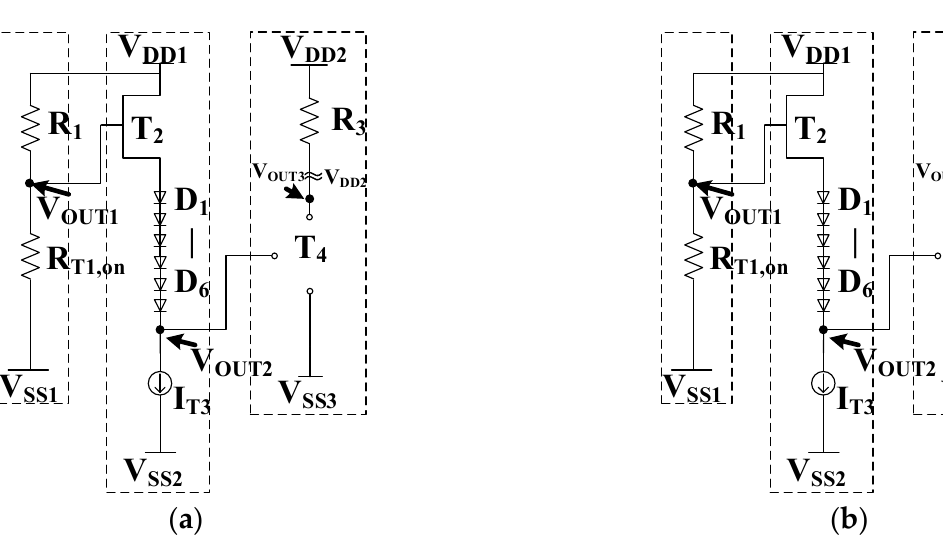
Figure 3. Simplified diagram for the operation of the high side driver, ( a ) V OUT3 output high level (close to VDD2) and ( b ) V OUT3 output low level (close to VDD2). Additionally then, comparatively low V OUT of the 2nd stage will be transmitted to the left side of the third stage and control T 4 to turn o ff , which make the V OUT3 (output of left side for the 3rd stage) output a high level voltage nearly approaching V DD2 (bias voltage of the left side for the 3rd stage). Simultaneously the low side driver accepts a low level signal (1.1 V) and outputs a low level voltage which is V OUT4 (output of right side for the 3rd stage) closing to V SS3 (common bias voltage of the 3rd stage). Vice versa, when V H is low (1.1 V) and V L is high (1.8 V) as shown in Figure 3b, V OUT3 will be close to V SS3 and V OUT4 will be close to GND.